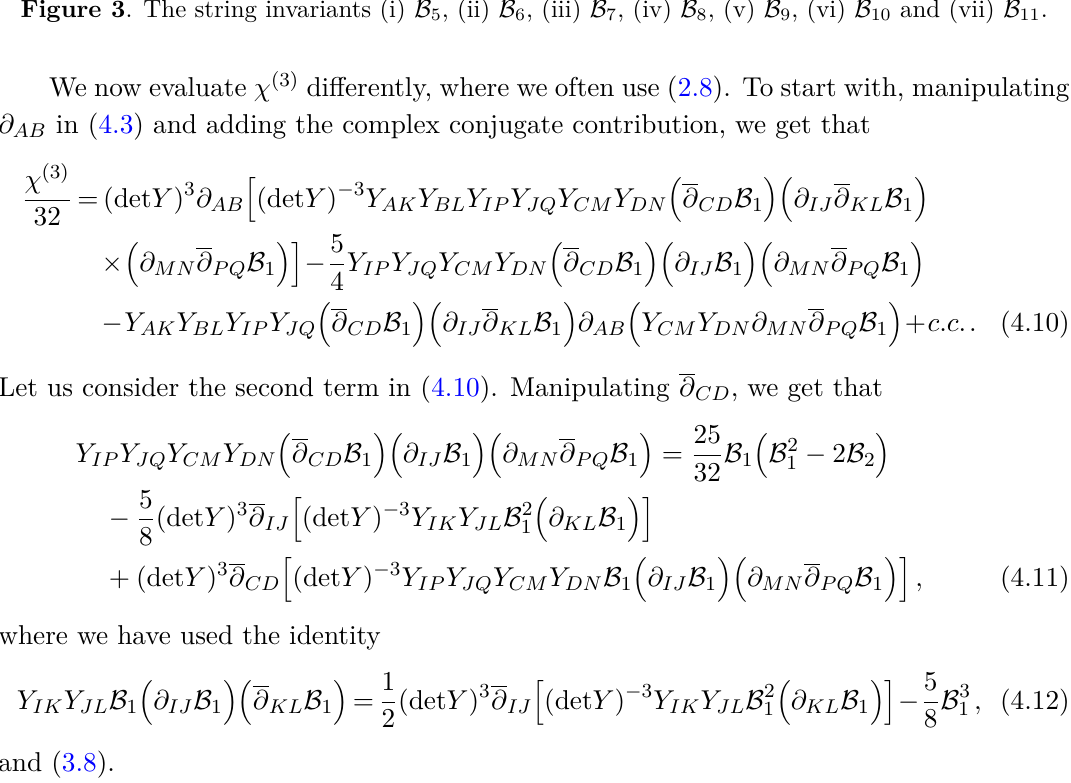
Figure 3 . The string invariants (i) B 5 , (ii) B 6 , (iii) B 7 , (iv) B 8 , (v) B 9 , (vi) B 10 and (vii) B 11